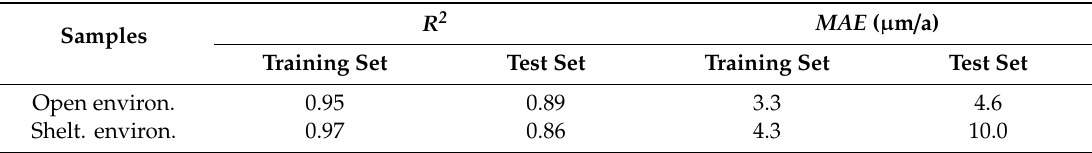
Table 3. The predictive accuracy of random forest models for steel samples under open and sheltered environments at the exposure test sites of Tsukuba, Choshi, and Miyakojima.